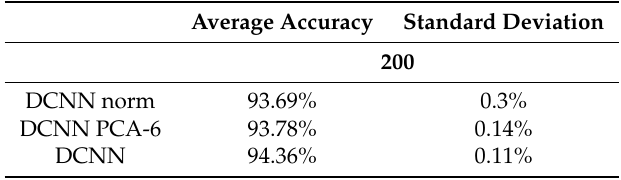
Table 14. Average accuracy scores and their standard deviation of the original train/test split of the WISDM dataset for different statistical feature processing